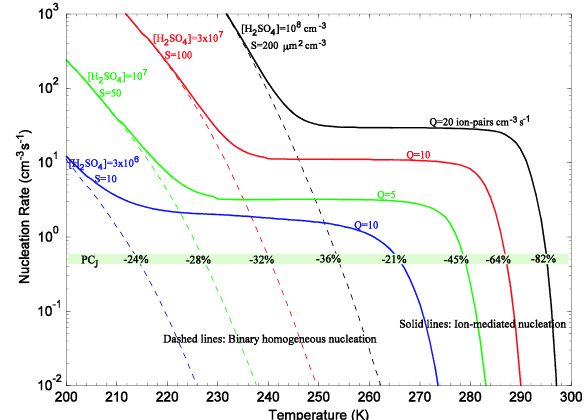
Figure 1. Fig. 1. Dependence of ion-mediated nucleation (IMN) rates (solid lines) and binary homogeneous nucleation (BHN) rates (dashed lines) on temperature ( T ) (RH=50%). The percentage change (PC) in the nucleation rate ( J) per ◦ C increase of T at J = 0 . 5cm − 3 s − 1 is also given for each case. Lines of same color have same sulfuric acid vapor concentration ([H 2 SO 4 ], in cm − 3 ) and the same local surface area density of pre-existing particles (S, in µm 2 cm − 3 ) . IMN rates also depend on ionization rate ( Q , in ion-pairs cm − 3 s − 1 ) . BHN is an integral part of IMN, and J IMN approaches to J BHN at low temperatures when BHN is